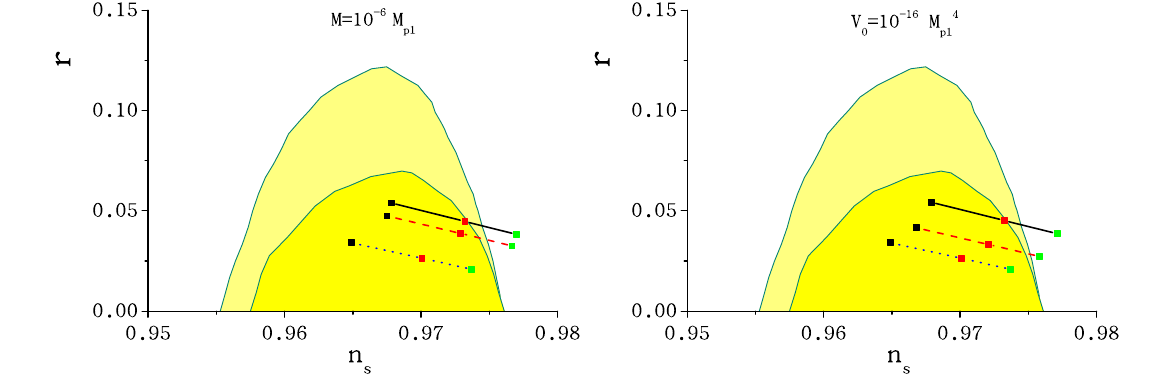
Fig. 3 1 σ (yellow) and 2 σ (light yellow) contours for Planck 2018 results (Planck + TT + lo w P ) [78], on the n s − r plane. Moreover, we depict the predictions of Table 2, of the scenario at hand for fixed α = 2, n = 4. In every line the first (black) point corresponds to e- folding number N = 50, the middle (red) point to N = 60, and the third (green) to N = 70. Left panel: Fixed M = 10 − 6 M pl . Black-